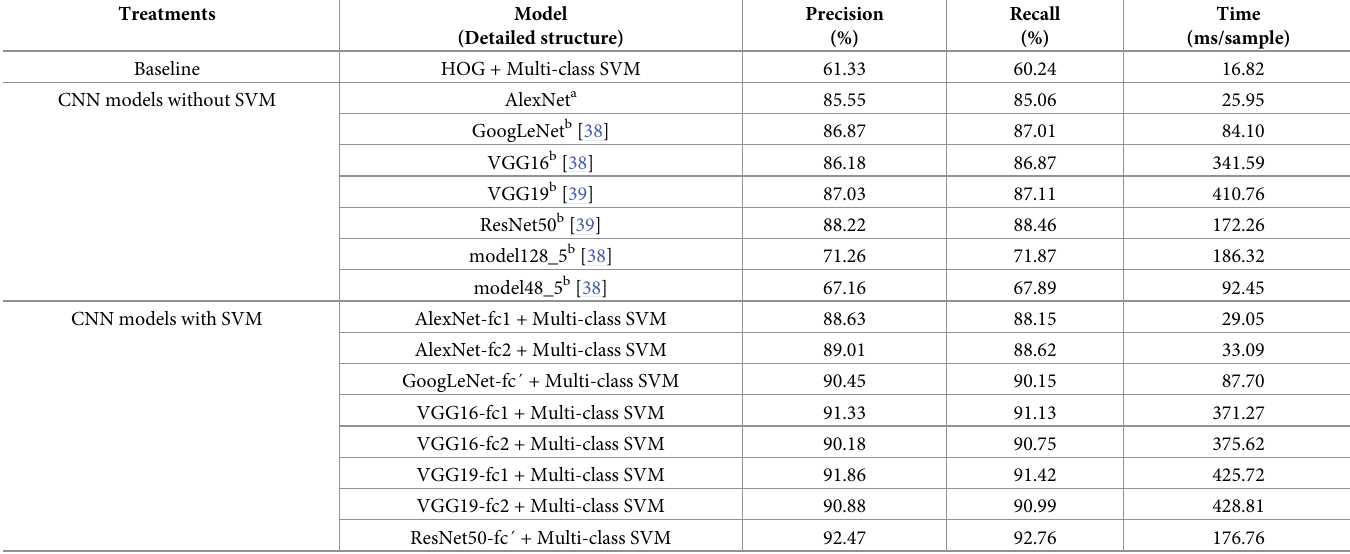
Table 1. Results of model performance.